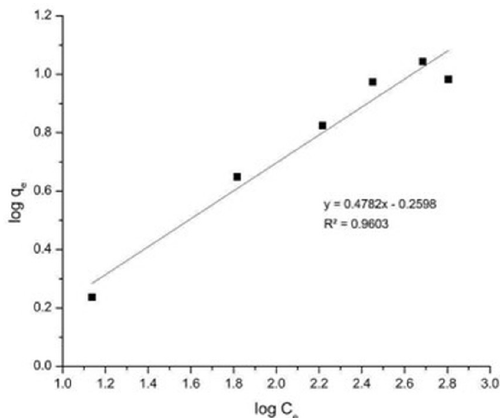
Figure 4. Linearized Freundlich adsorption isotherm